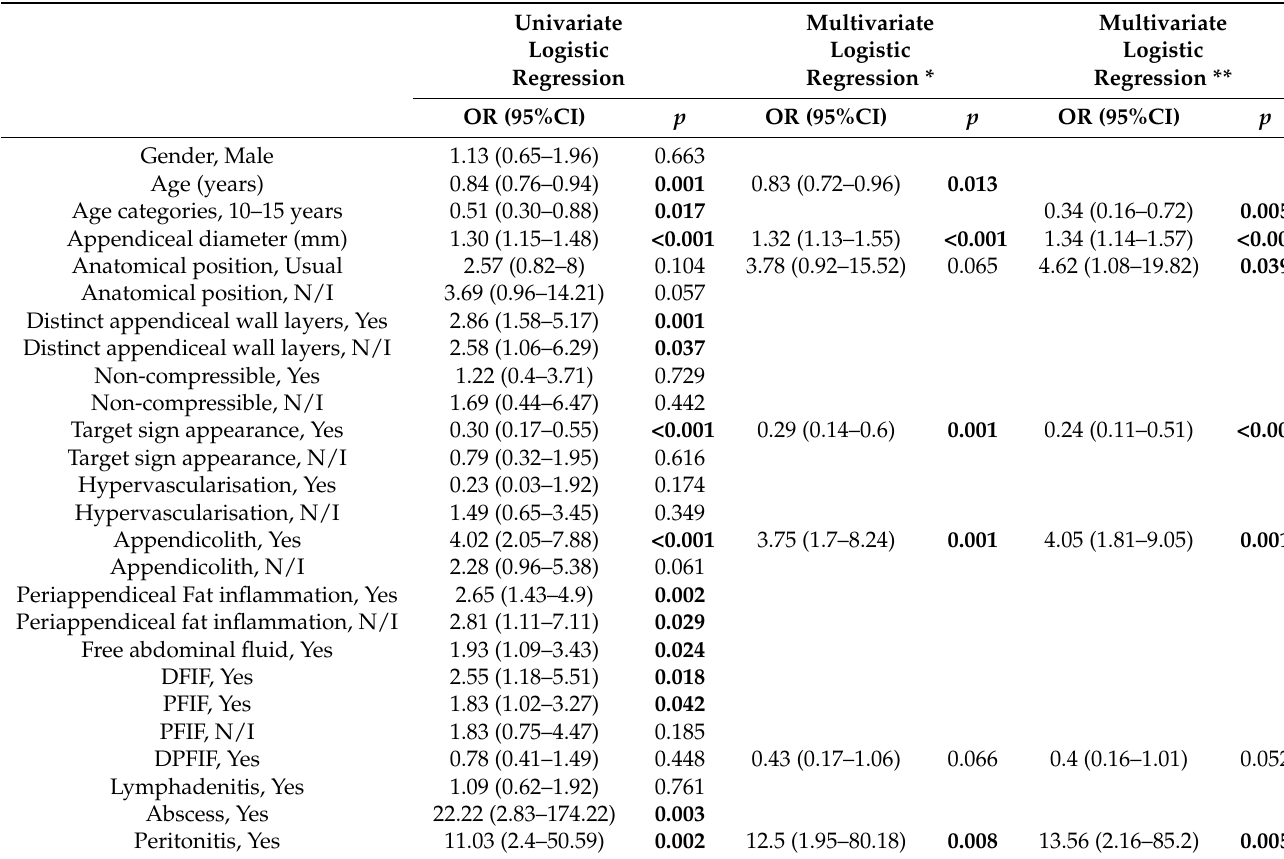
Table 2. Logistic regression analysis for ACA and US findings.